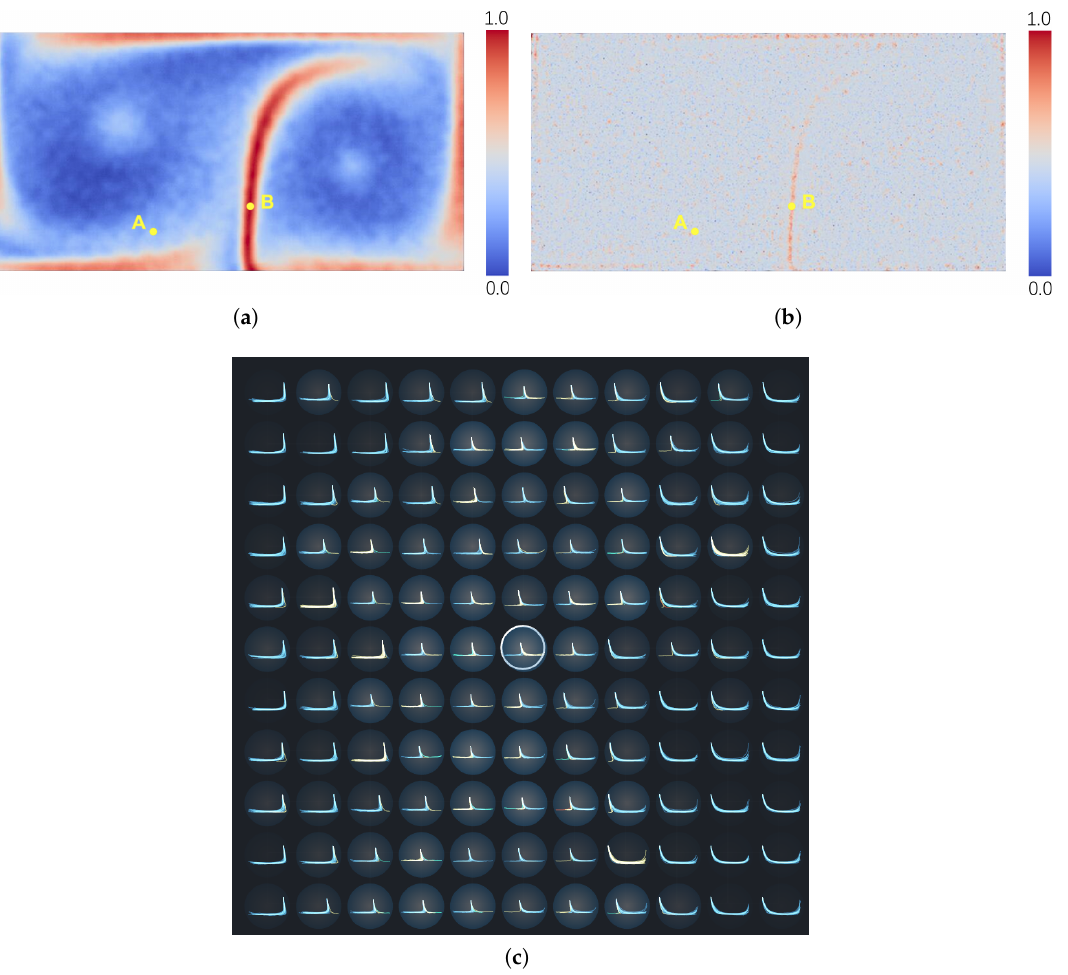
Figure 11. Transport patterns in the Double-Gyre (DG) data set: ( a ) rendering of neighborhood uncertainty (NU), ( b ) rendering of uncertainty correlation (CU), and ( c ) comparison view of location “B” in subfigures ( a , b